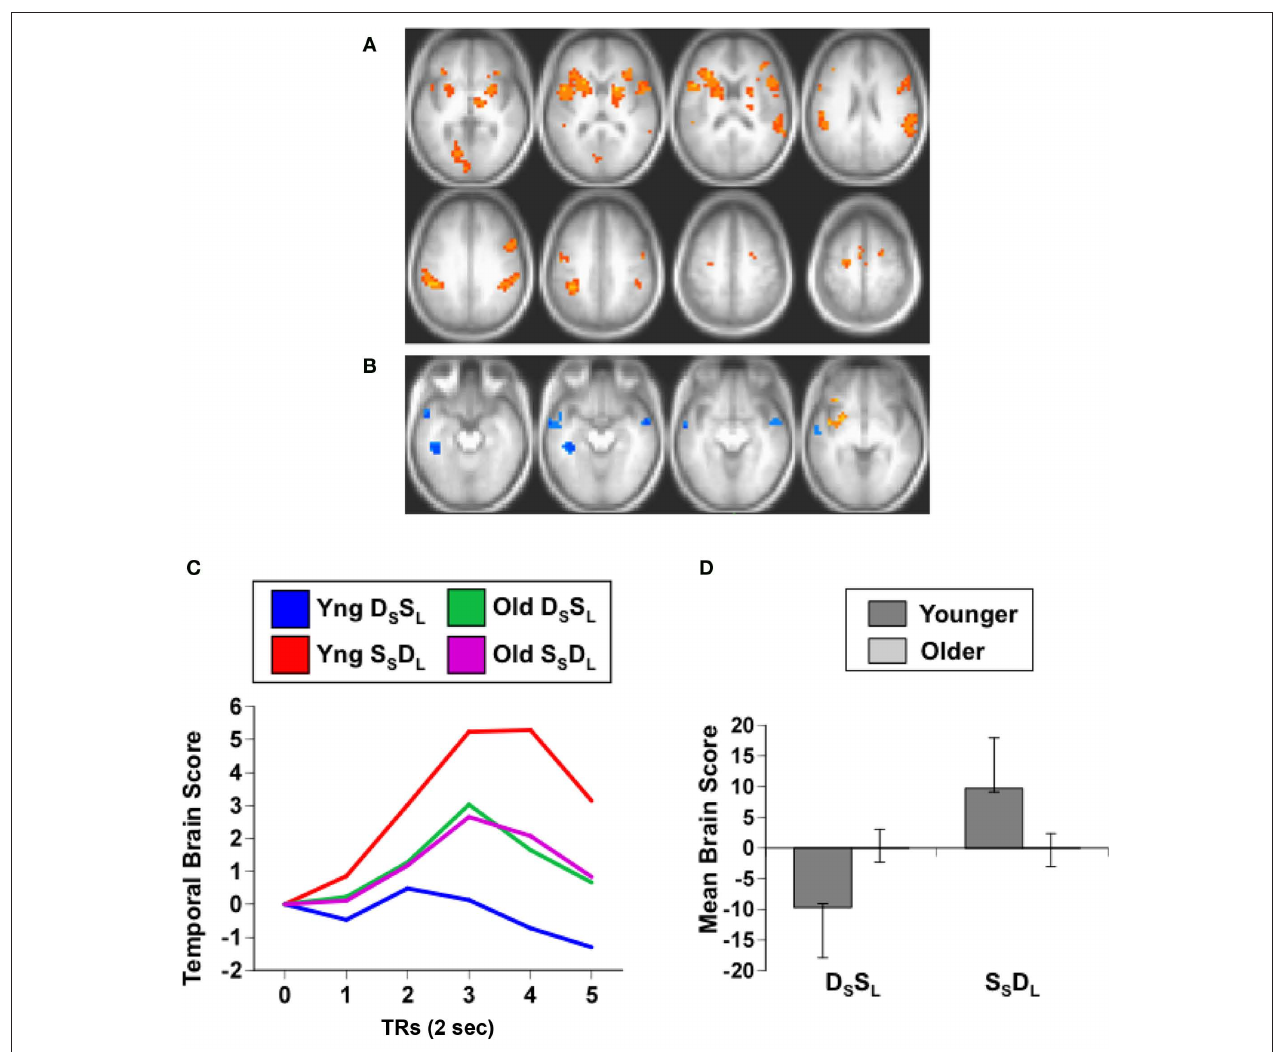
and mean centered (zero in the graph represents overall mean activity). Error S and S D conditions. (A) S L S L bars are the 95% confidence intervals (CIs) calculated from the bootstrap. D than S L Non-overlapping CIs between conditions in young adults indicate different activity patterns in the two conditions. Overlapping CIs for older adults indicate S than in S D ; images are S L S L no difference between conditions, and activity does not differ from the overall mean in either condition. Non-overlapping CIs between groups indicate an age difference for both